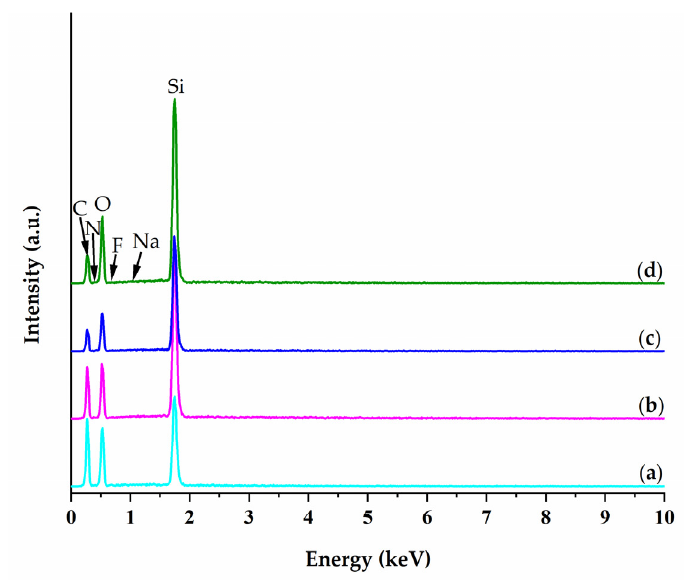
Figure 4. EDS spectra of the investigated biocatalysts: ( a ) SG6—PhTMOS:TMOS (1:1); ( b ) SG9—